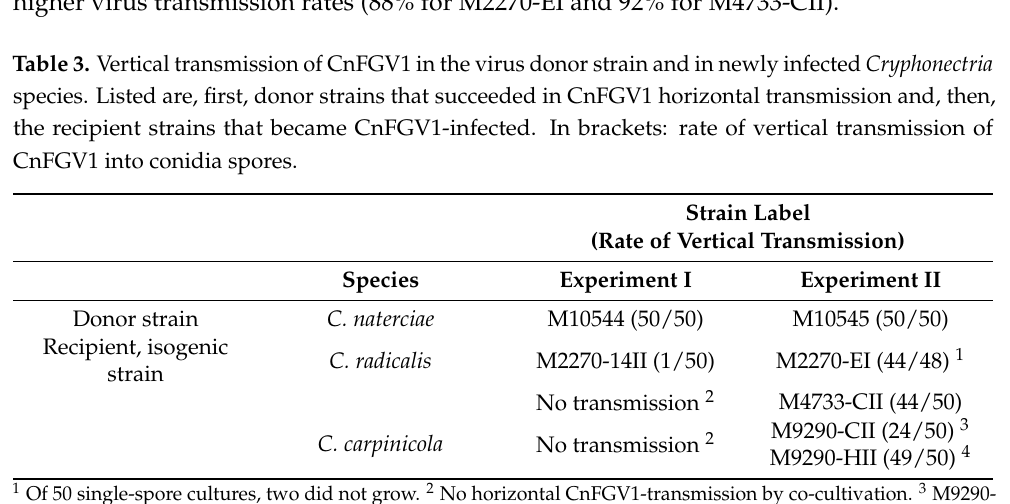
Table 3. Vertical transmission of CnFGV1 in the virus donor strain and in newly infected Cryphonectria species. Listed are, first, donor strains that succeeded in CnFGV1 horizontal transmission and, then, the recipient strains that became CnFGV1-infected. In brackets: rate of vertical transmission of CnFGV1 into conidia spores.